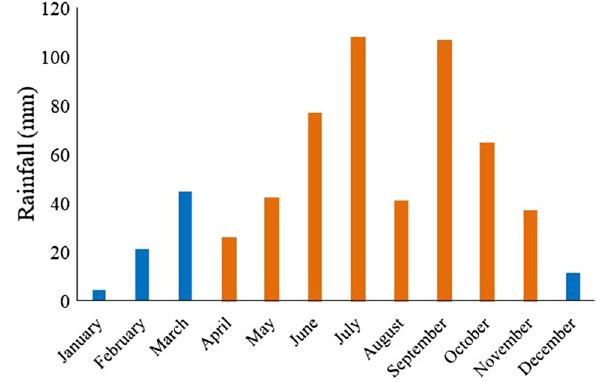
Fig. 40 Maximum annual rainfall in the study area